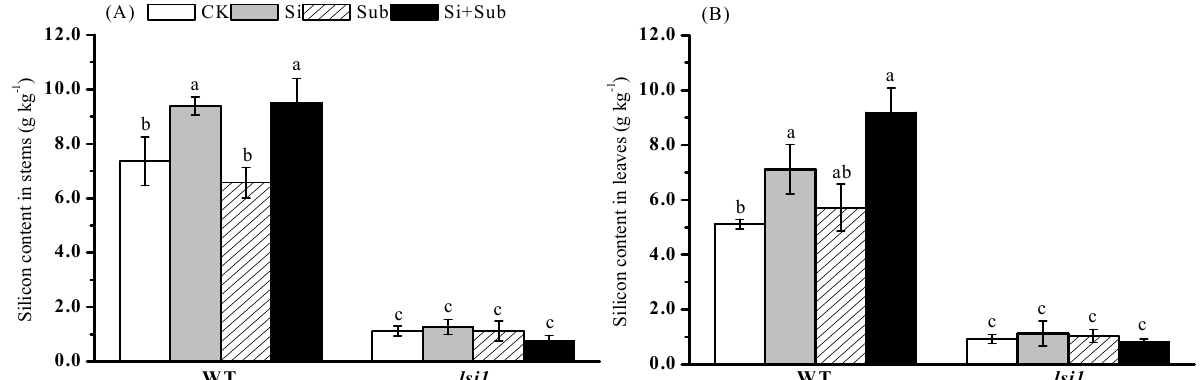
Figure 3. Effects of Si application on Si concentration in rice stem ( A ) and leaf ( B ) under submergence stress. Values are expressed as mean ± SE from three replicates (n = 3). The different letters above the bars indicate significant differences among all treatments ( p < 0.05). WT, wild type.